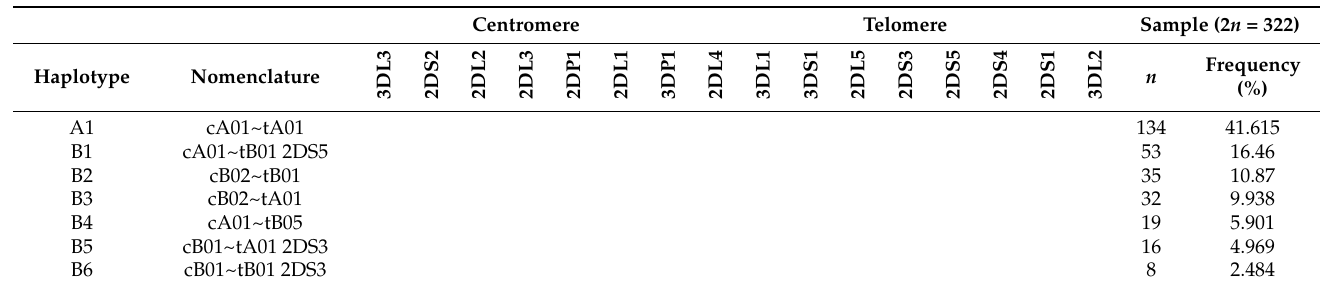
Table 2. Most frequent KIR inferred